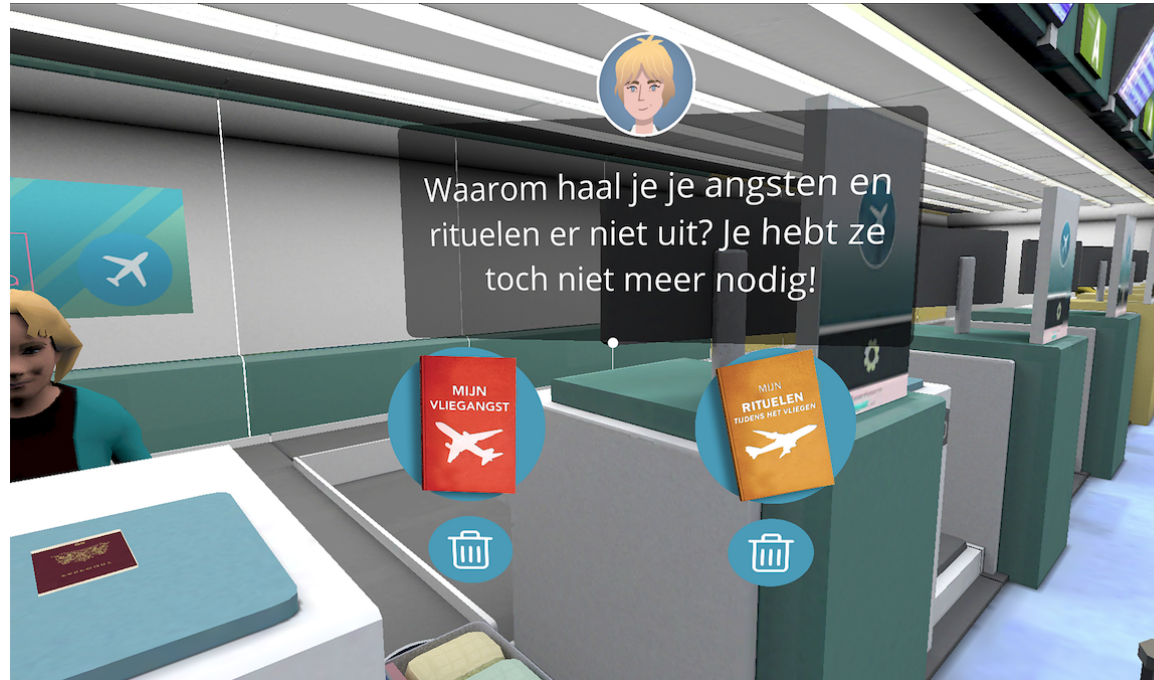
Figure 4. Virtual Reality Level 1: Checking In. The text in the therapist's speech bubble translates to “Why don’t you take your fears and rituals out (of your suitcase)? You don’t need them anymore!” The text on the red book translates to “My Flight Anxiety”. The text in the yellow book translates to “My Rituals During Flights”.